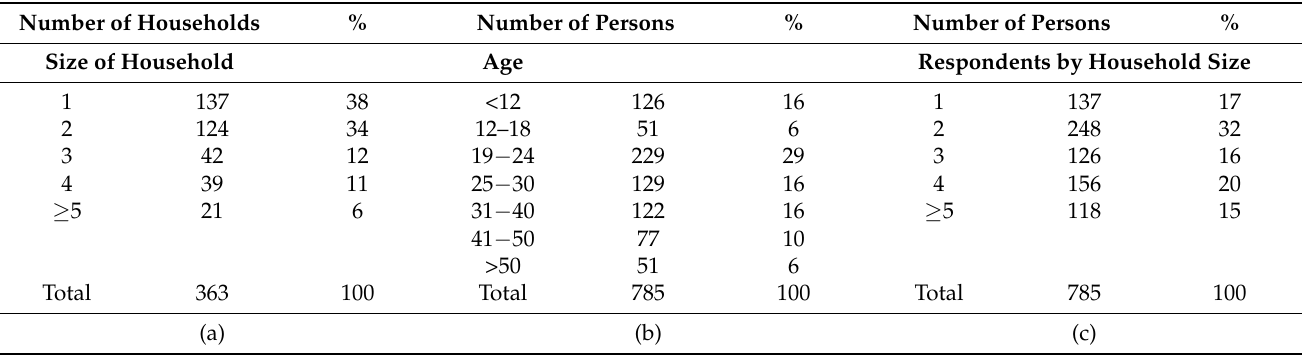
Table 1. The respondents divided by the ( a ) size of households, ( b ) age of the persons living in the various-sized households, and ( c ) number of respondents in all households.